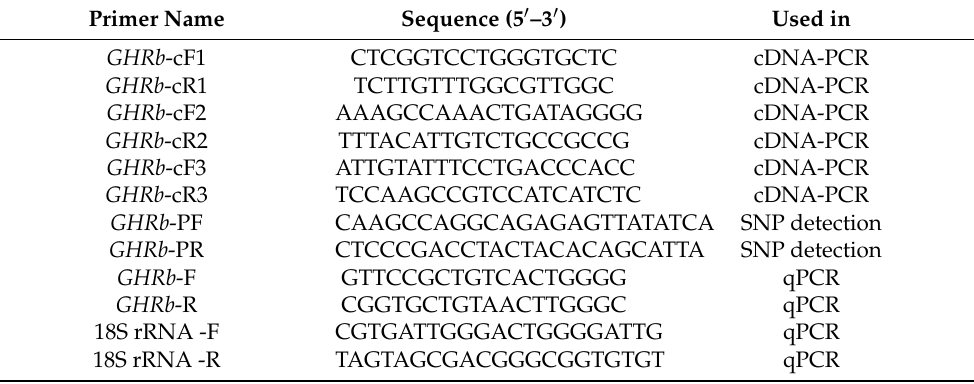
Table 1. Primers used in this